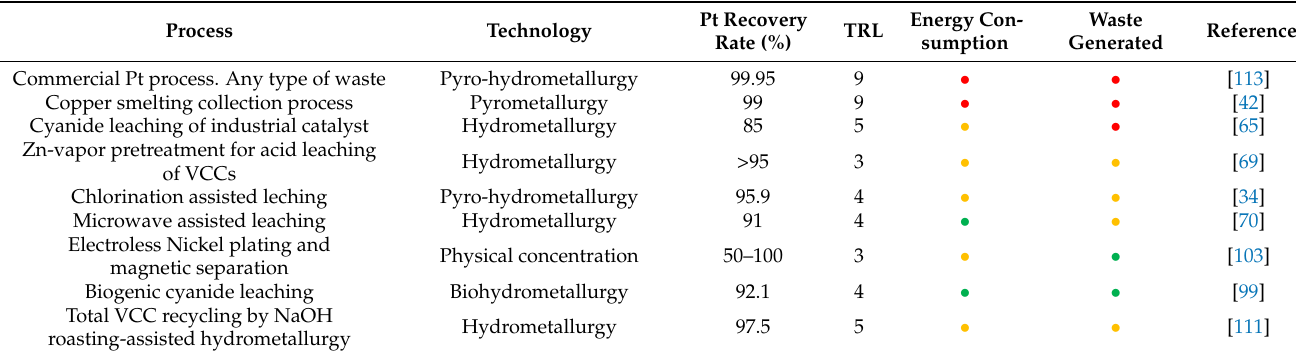
Table 1. Comparison of different Pt recovery technologies in terms of Pt recovery rate (%), TRL (Technology Readiness Level from 1–9), energy consumption (being red, yellow and green a high, moderate and low, respectively) and waste generation (being red high volume and toxicity, yellow, moderate volume and toxicity and green, low or negligible waste generation). Process Technology